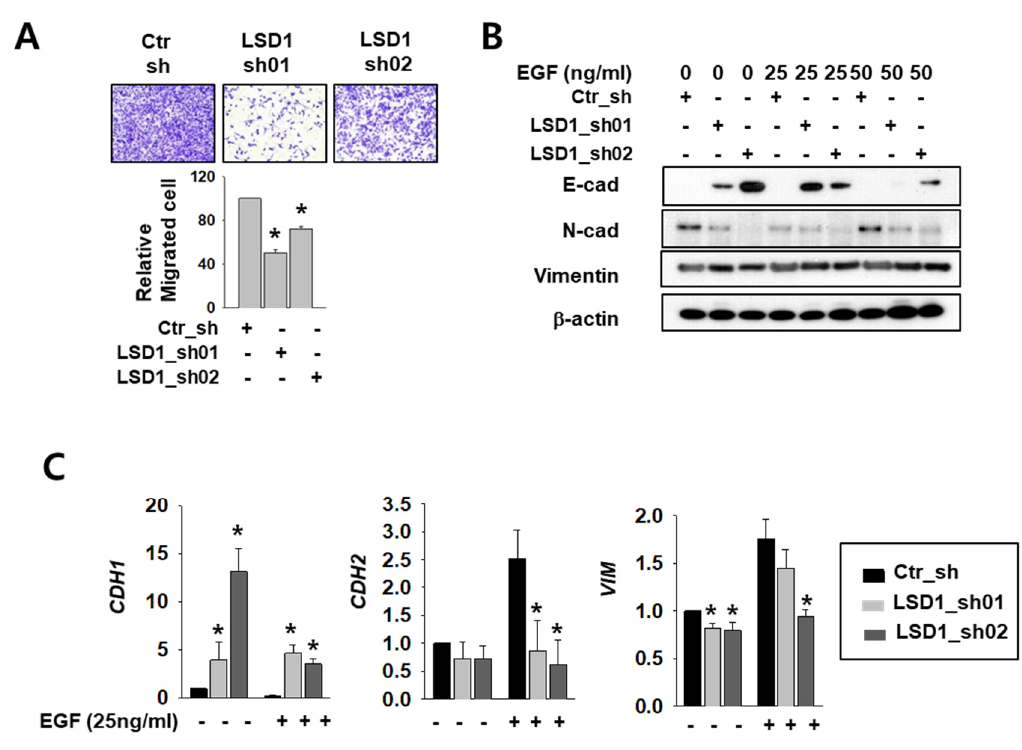
Figure 3. LSD1 knock-down reduces cell mobility and epithelial–mesenchymal transition (EMT)-related gene expression in kidney cancer cell lines. ( A ) The transwell infiltration assay of the same number of indicated shRNA-expressing Caki-2 cells was observed after two days of incubation. Cells that had migrated to the underside of the filters were fixed and photographed. Graph presents the invasion rate as the mean percentage of control. Error bars represent the mean ± SD of three independent experiments and * denotes p < 0.05 (Student’s t -test) versus ctr_sh group. ( B ) Western blotting of indicated EMT markers after 24 h treatment with indicated concentrations of epidermal growth factor (EGF) in control or LSD1 shRNA-expressing cells. ( C ) Quantitative PCR was used to examine the transcriptional level of the EMT marker genes in Caki-2 cells expressing control or LSD1 shRNA after two days of EGF treatment. Error bars represent the mean ± SD of three independent experiments and * denotes p < 0.05 (Student’s t -test) versus ctr_sh